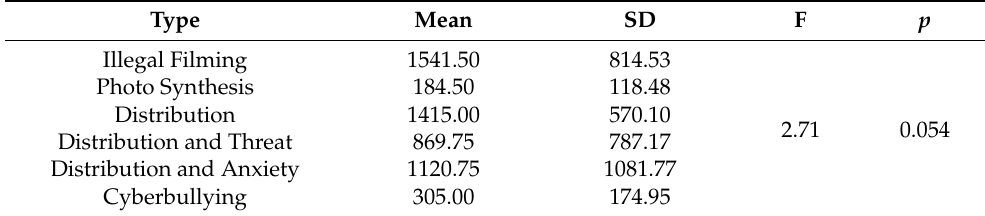
Table 9. Type of Digital Sex